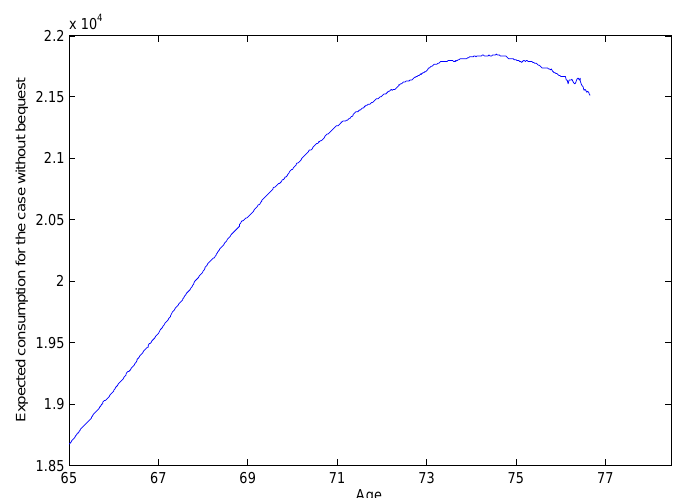
Figure 1. Expected consumption path for case 1 retirees, starting in the healthy state at age 65 with total wealth of 10 Y , and truncated at the optimal case 1 stopping times. This captures the expected consumption outcomes of agents with no bequest motive. Note that these agents have no access to insurance markets, and are assumed to purchase a term certain annuity to protect their basic consumption needs—which is much more expensive than a life annuity, particularly at older ages.